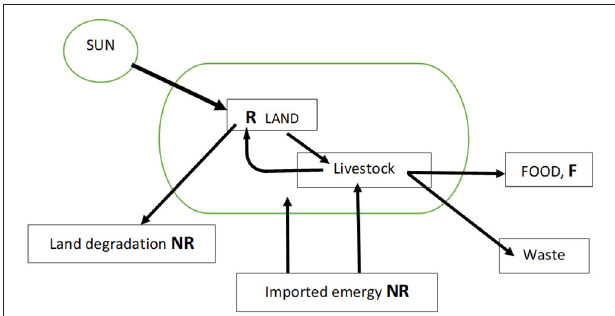
FIGURE 1 | The “Emergy” approach to the evaluation of renewable (R) and non-renewable (NR) sources of energy and matter to the production of food for human consumption.